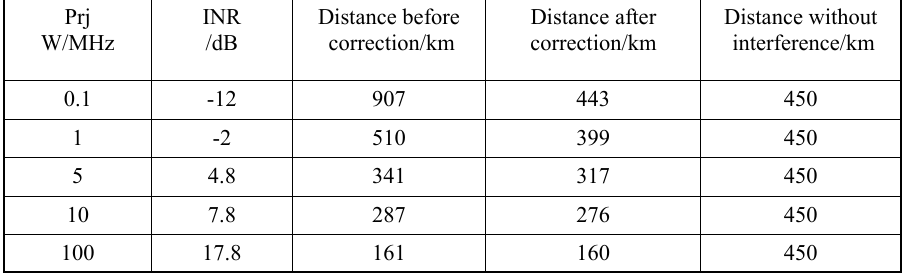
Table 1. Comparison of the radar sidelobe self-defence distance before and after correction.